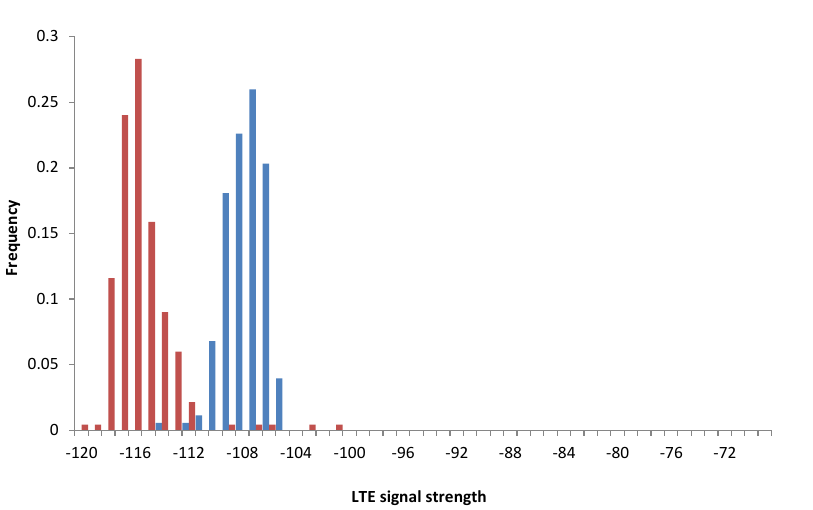
Figure 13. Signal strengths for two different locations in the same office room (Experiment